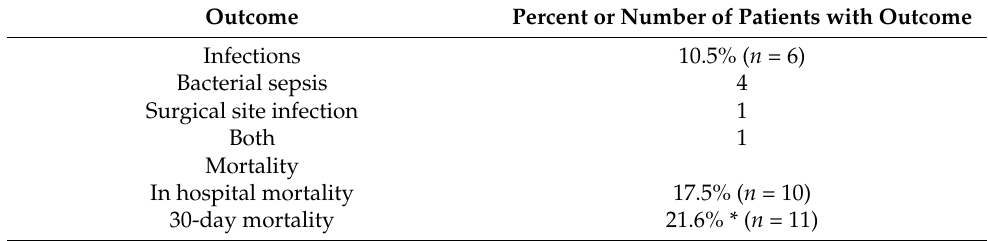
Table 4. Survival and infectious outcomes. Infections were overall uncommon. Mortality occurred in less than one-third of cases. * 30-day status was not available for 6